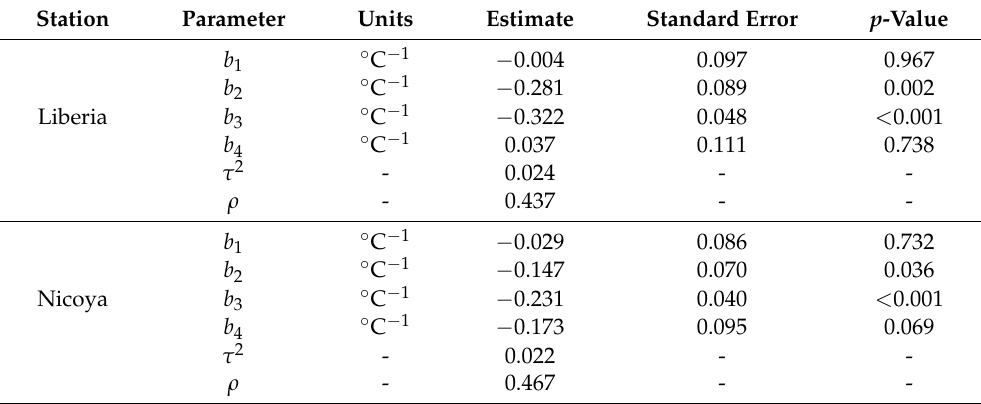
Table 3. Estimates and standard errors of some of the parameters of the Tweedie